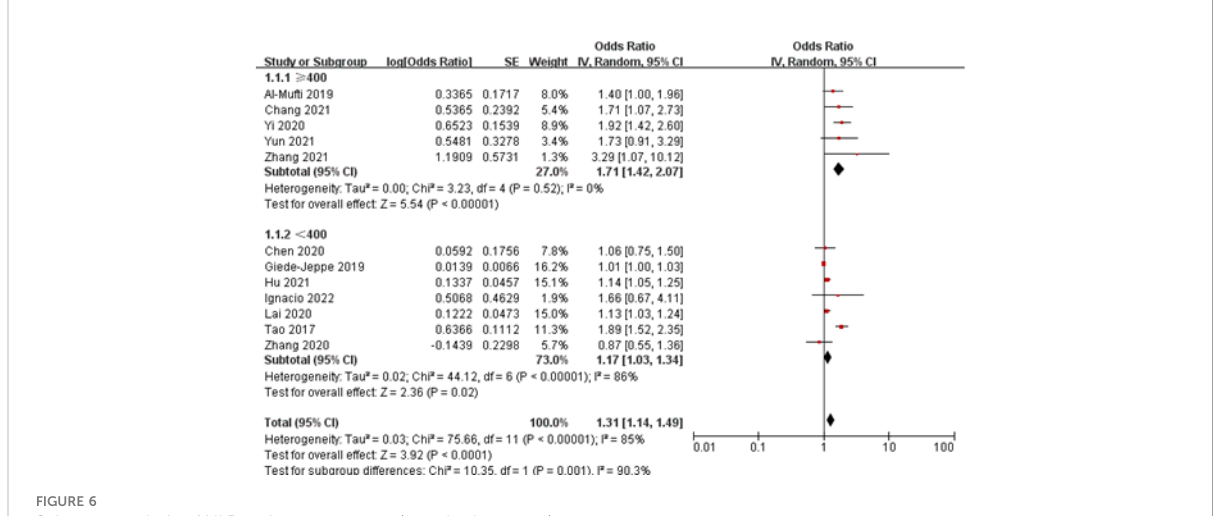
FIGURE 6 Subgroup analysis of NLR and poor outcome (sample size group).